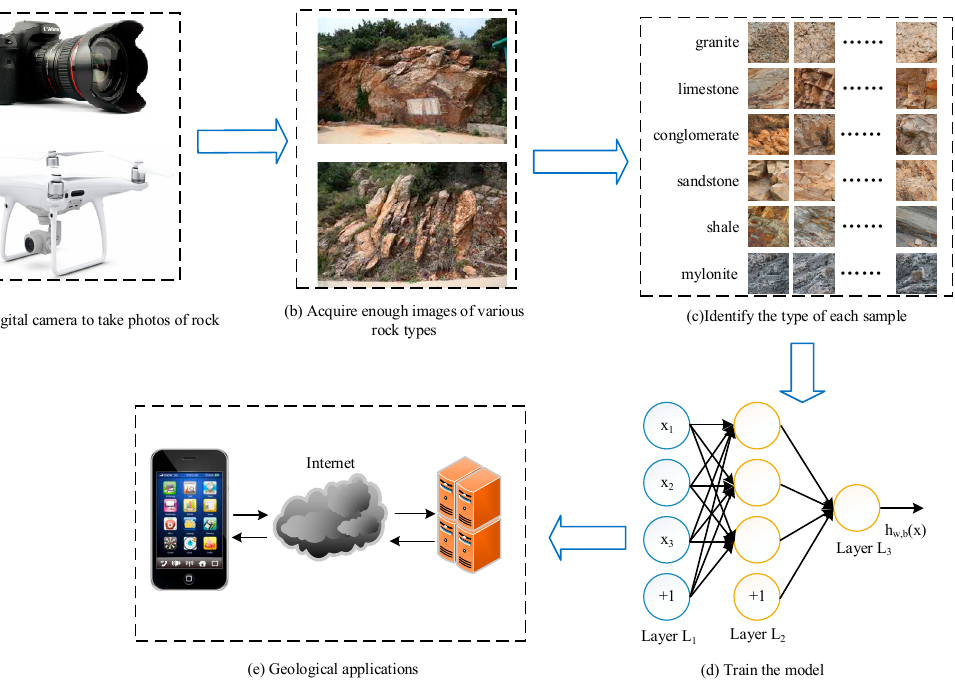
Figure 4. Whole flow chart for the automated identification of field rock types. ( a ) Cameras: Canon EOS 5D Mark III (above) and a Phantum 4 Pro DJi UAV with FC300C camera (below). ( b ) Rock images obtained from outcrops. ( c ) Cutting images (512 × 512 pixels) of marked features from the originals. ( d ) Rock-type identification training using CNNs. ( e ) Application of the trained model to related geological fields.